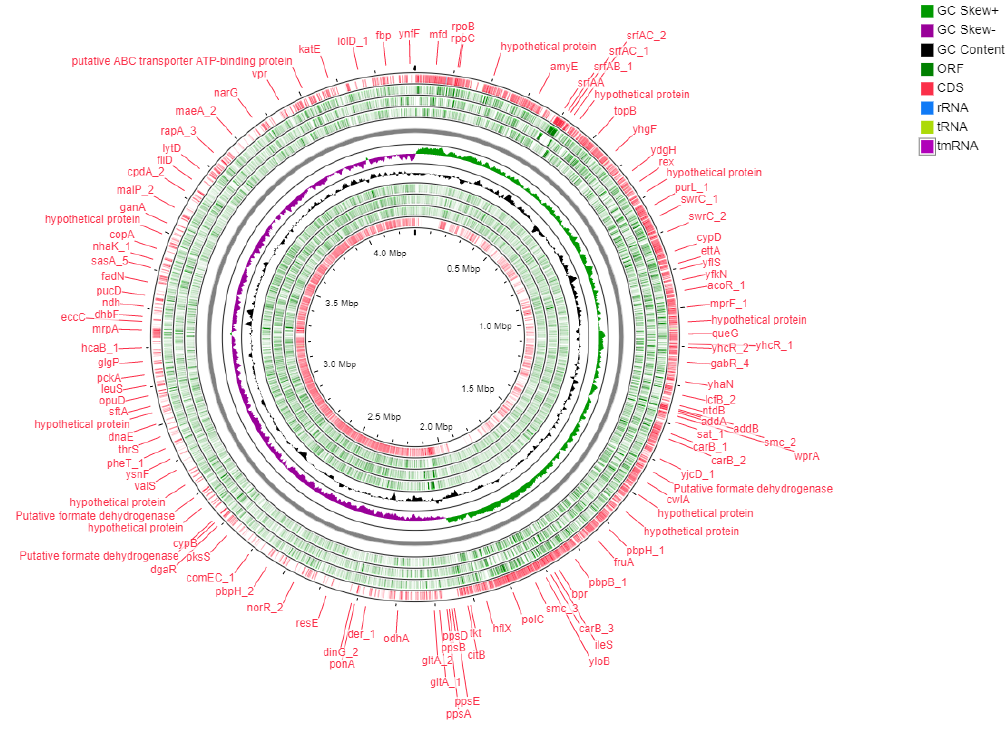
Figure 7. Genome map of Bacillus subtilis Bbv57. A circular map of the strain Bbv57 genome was constructed using a CG viewer.